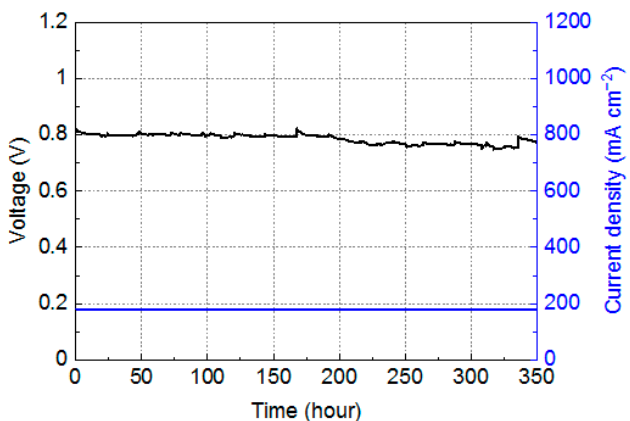
Figure 6. Plot of the cell voltage over time in constant-current operation of the MEA employing the Hex-SPAES-40 membrane.